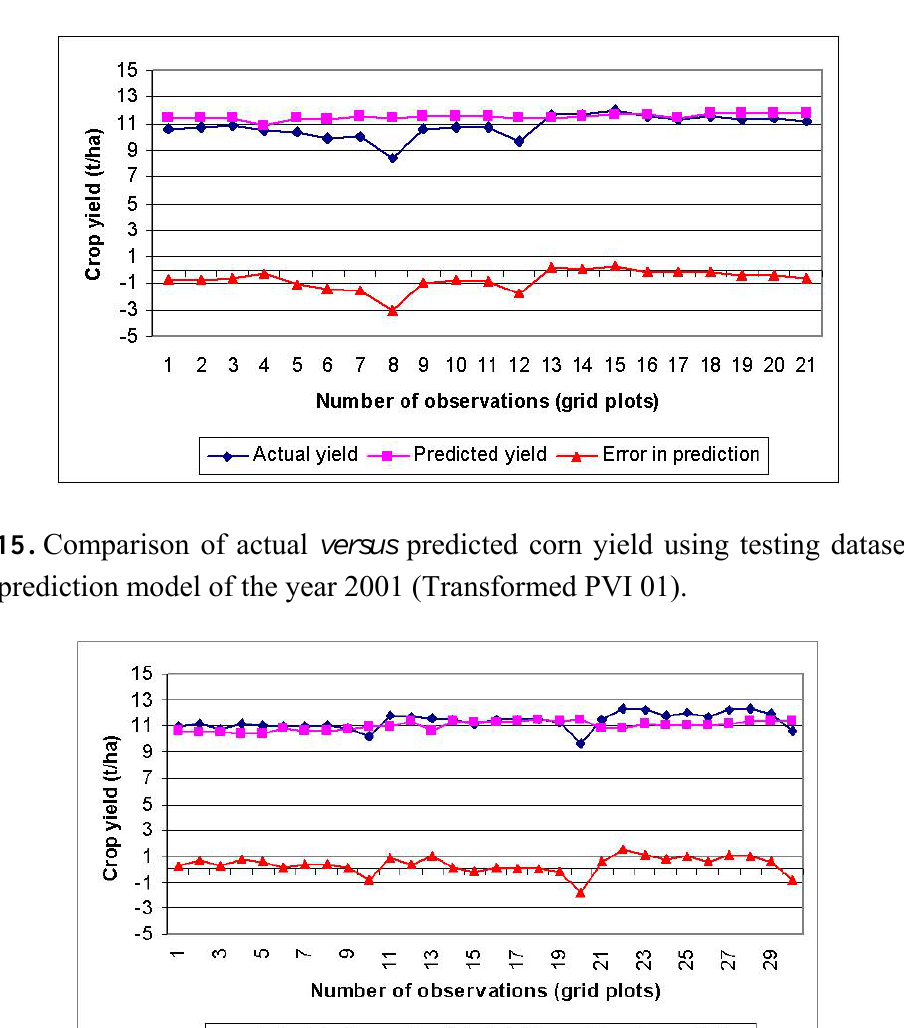
Figure 14. Comparison of actual versus predicted corn yield using testing dataset of the optimal prediction model of the year 1999 (Transformed PVI 99).